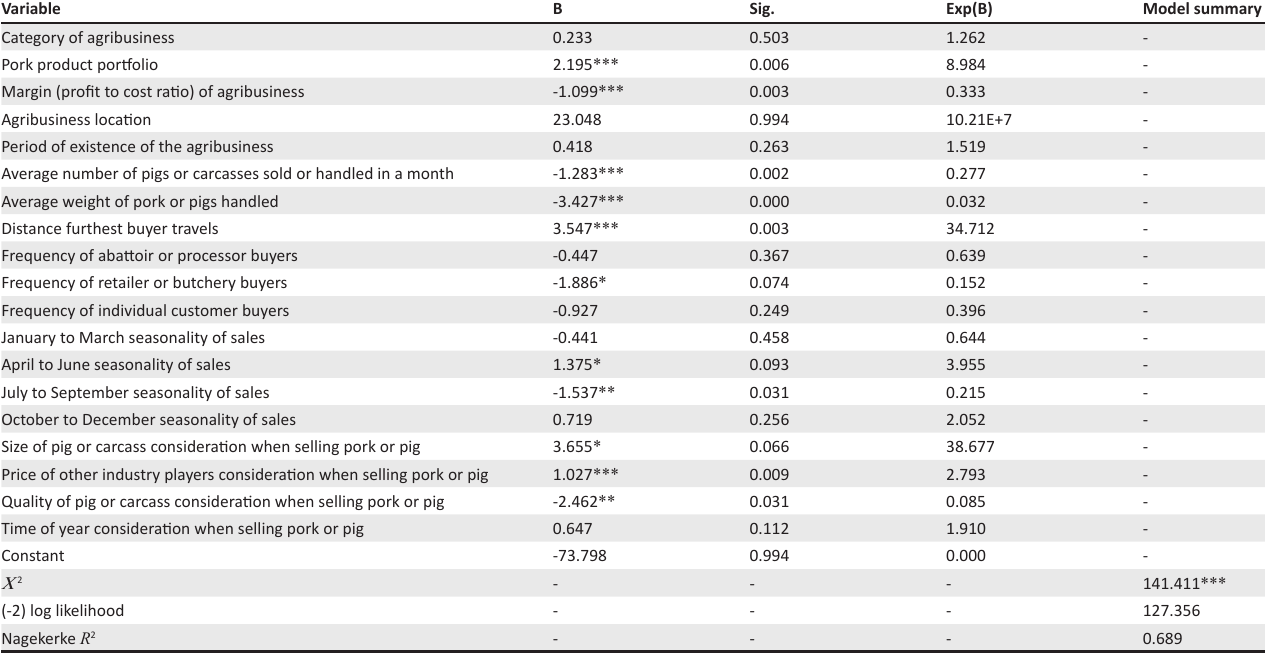
TABLE 6: Empirical binary logistic results of choice of pricing objectives. Variable B Sig. Model